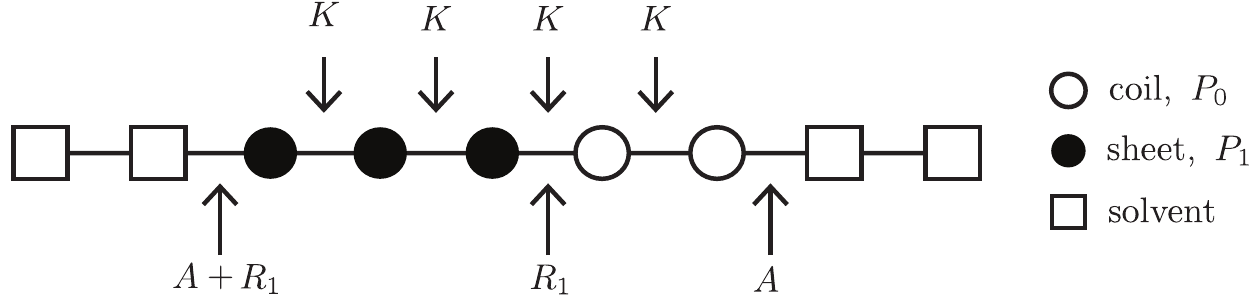
Figure 10. Summary of protein conformation energies. A site could be occupied with a solvent cluster, denoted by n = 0 (square), or a protein, n = 1 (circles). Proteins may assume a particular conformation (sheet, black/solid circle; coil, white circle). A dilute q = 2 Potts model for sheet-coil conformations is shown, where n P , K , R , and A are 1